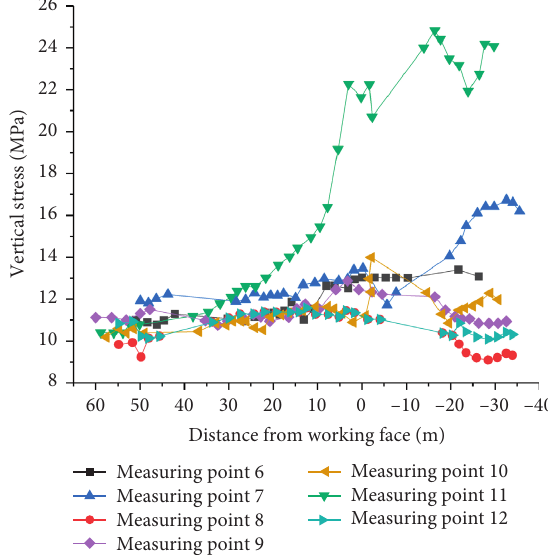
Figure 26: Variation curve of side abutment pressure.